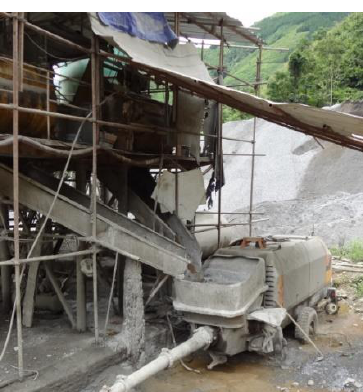
Figure 2. Pumping SCC into the working space.